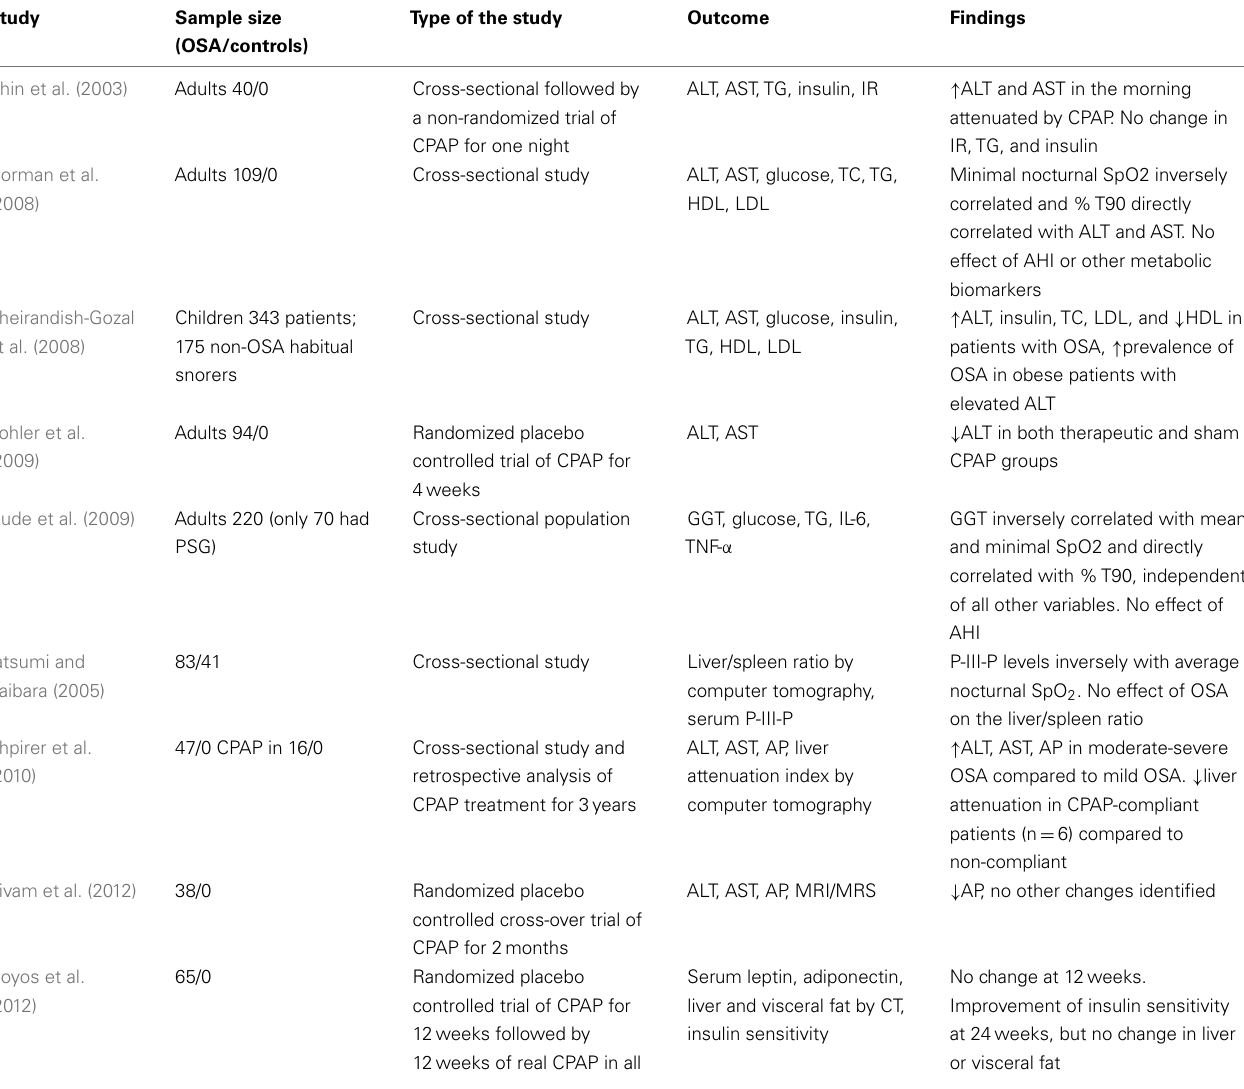
Table 1 | Studies that measured liver enzymes and/or imaged liver in patients with